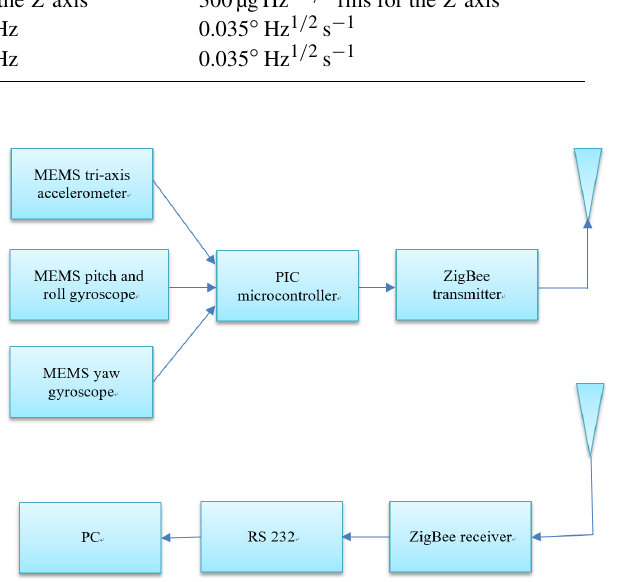
Figure 1. Block diagram of the designed MEMS gesture interaction